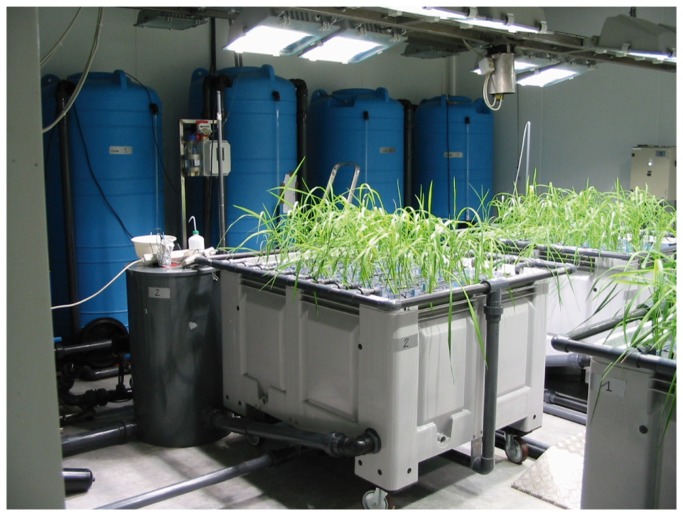
General view of the Rhizoscope phenotyping system.